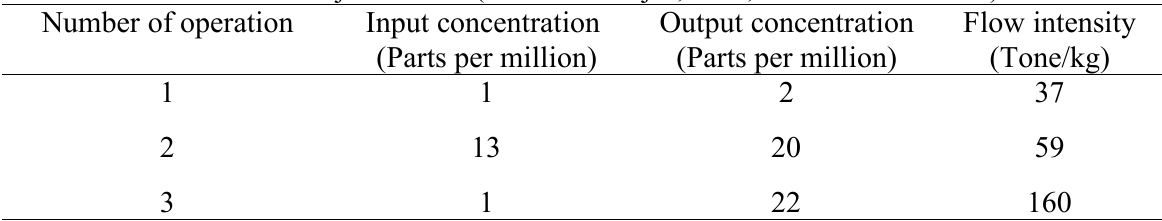
Table 2. Data of Mohammadnejad research (Mohammadnejad, 2010; Mehrdadi et al.